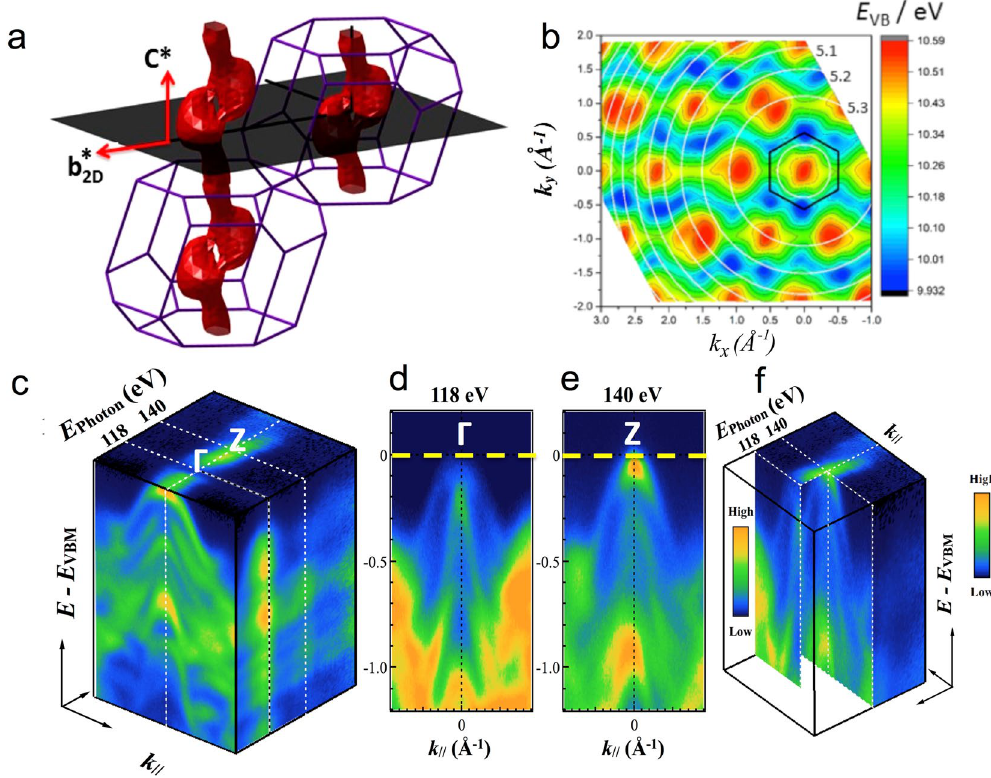
Figure 5. Three-dimensional electronic band structure of the ReSe 2 ( a ) Perspective view of the Brillouin zone: red surface: the constant energy surface for the valence band states at 80 meV below the valence band maximum. The shaded plane shows a plane parallel to the crystal layers; this is the plane sampled in an ARPES experiment at a given excitation phonon energy (neglecting the curvature due to momentum conservation discussed in the text). ( b ) Energy E VB of the highest-lying valence band state as a function of in-plane momenta k x and k y , calculated taking into account the variation of the momentum k z normal to the layer expressed by equation 1. White circles indicate contours of constant k z (three are labelled, top right, by their values in units of 2 π / c * ) and the black hexagon shows the in-plane quasi-unit cell of Fig. 1(c) and (f) nano-ARPES signal (blue = low to orange = high) as a function of energy below the Fermi energy (vertical axis) and in-plane momentum k xy , for excitation energies of 118 and 140 eV (left and right respectively). (d) and (e) panels show the nano-ARPES electronic dispersion of the valence bands at the Γ and Z points of the 3D Brillouin unit